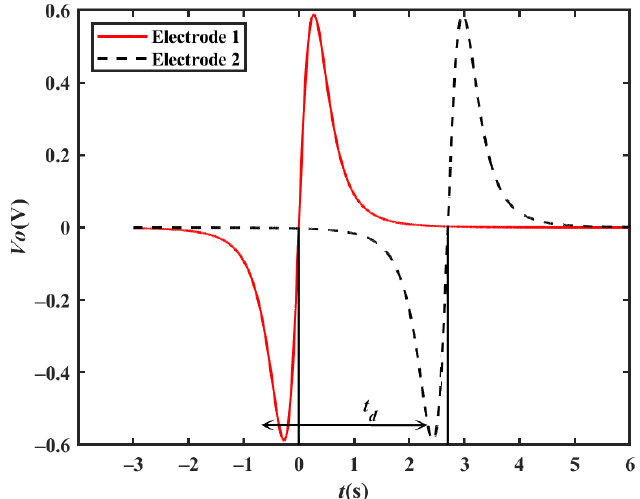
Figure 10. Velocity measurement